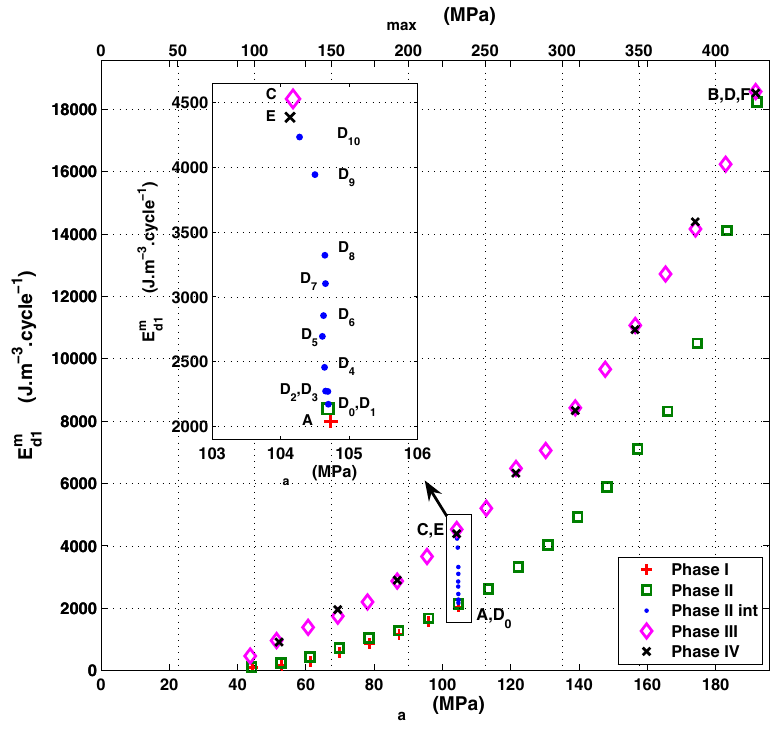
Fig. 3. Dissipative energy measurement E m (top